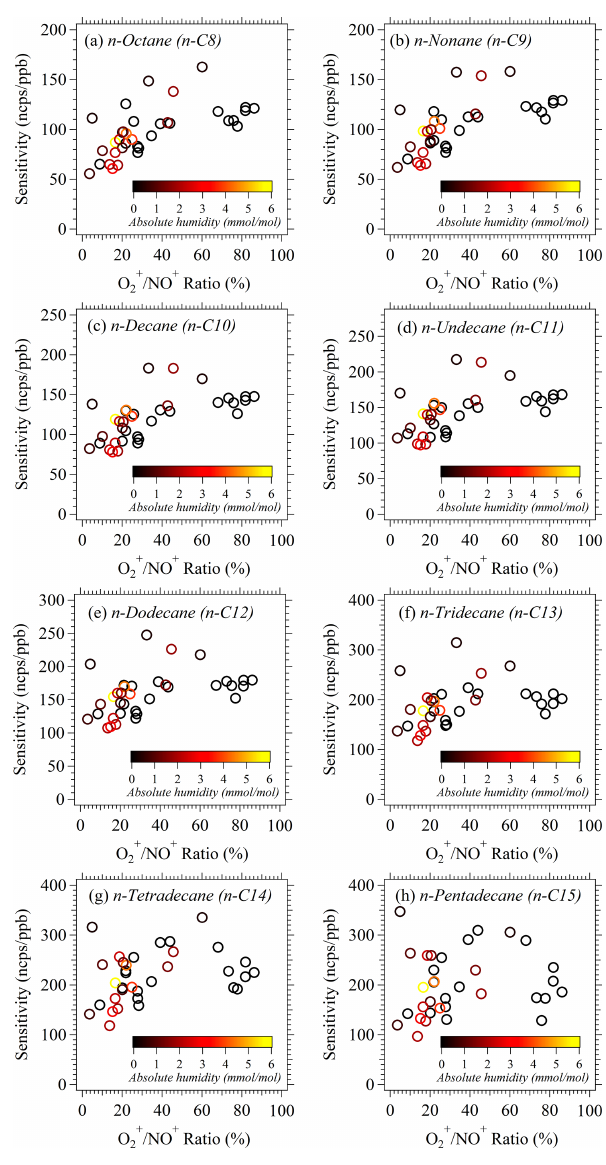
Figure 2. The relationship of sensitivities of n -alkanes (C8–C15) / NO + ratios during the NCP campaign. The data points are vs. O + 2 color-coded using absolute humidity during the